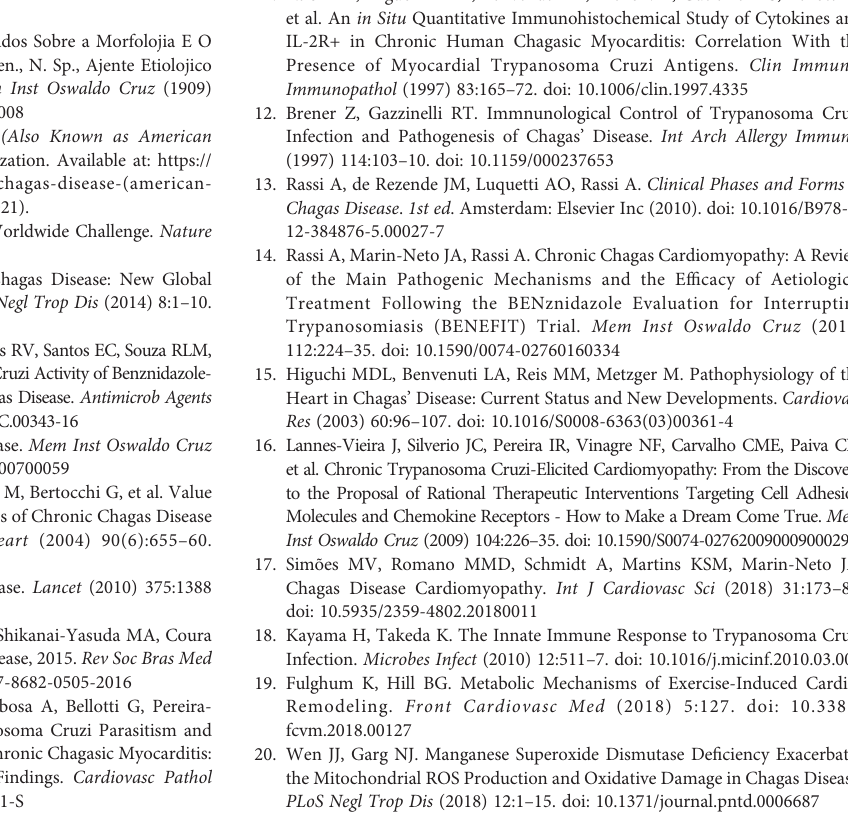
Supplementary Figure S1 | T. cruzi -infected C57BL/6 mice presented electrical abnormalities at 120 and 150 dpi. (A) At 120 dpi. (B) At 150 dpi. ECG records showed the average heart rate (beats per minute, bpm), P wave duration (ms), variation in PR and QTc intervals, and QRS complex (ms). The data are represented as means ± SEM. Data represent eight to nine mice per group. Signi fi cant differencesbetweeninfectedanduninfectedgroups *P<0.05( Mann – Whitney test). Supplementary Figure S2 | Effect of T. cruzi infection and physical exercise on CK-MB, mitochondrial and antioxidant activities in C57BL/6 mice. (A) CKMB activity. (B) Mitochondrial complex and antioxidant activities. Data are represented as means ± SEM. Data represent six to eight mice per group ( Mann – Whitney ; Kruskal – Wallis test , Dunn ’ s posttest